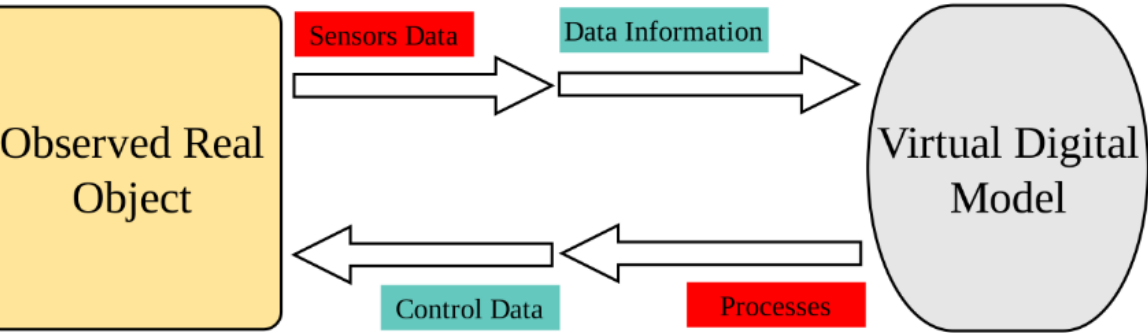
Figure 6. Representation of a real-time bidirectional matched observation-model